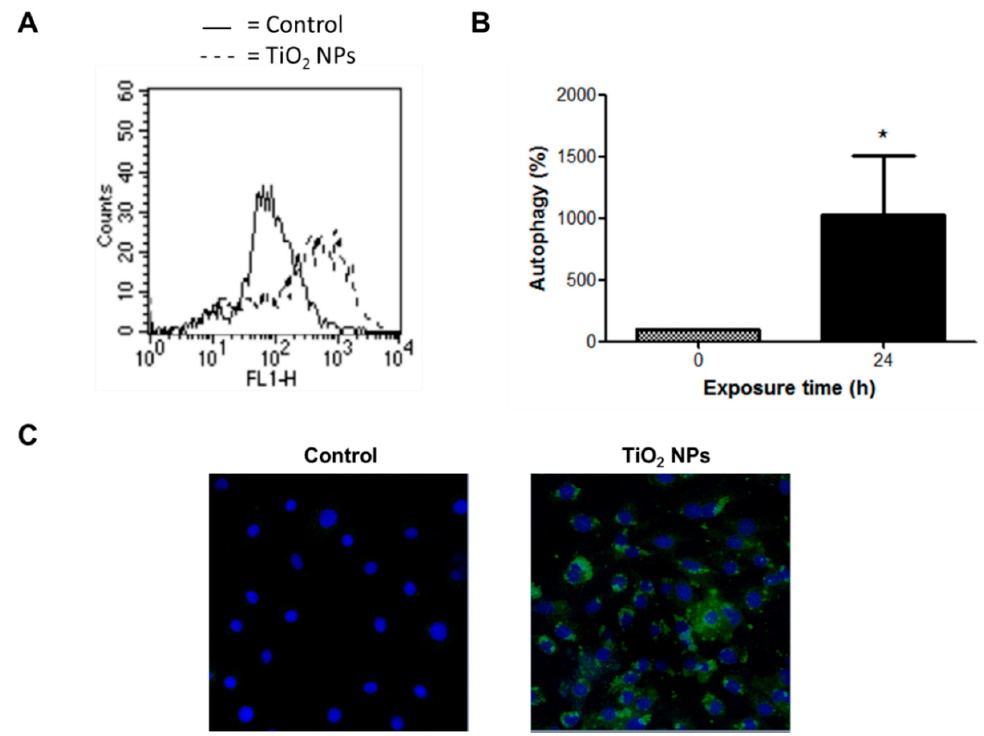
Figure 8. TiO 2 NPs induced autophagy. H9c2 cells were treated with 20 μ g/cm 2 TiO 2 NPs for 24 h and autophagy was evaluated through a detection kit by flow cytometry ( A , B ) and confocal microscopy ( C ). In ( B ), results are presented as mean ± standard deviation (SD) of three independent experiments ( n = 3). * Significant difference between untreated cells (0) and TiO 2 NPs ‐ treated cells ( p < 0.05). In ( C ), nuclear stain with DAPI and green detection reagent (autophagy) are showed.